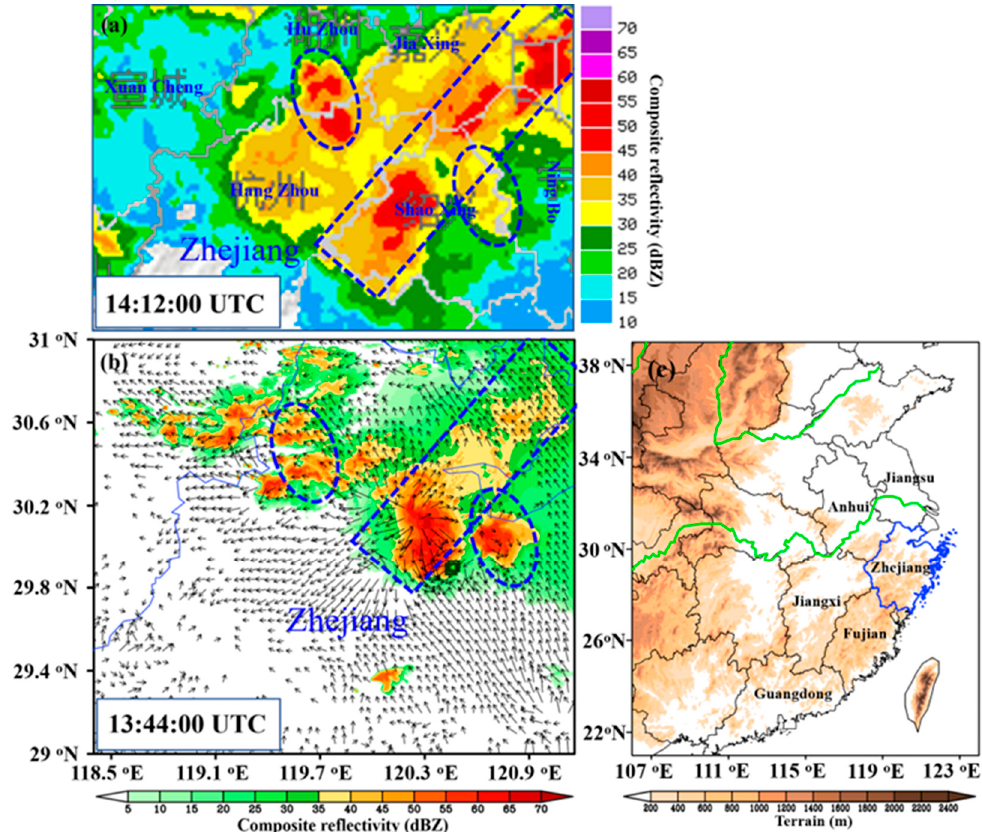
Figure 1. ( a ) Observed composite radar reflectivity (shading; dBZ) at 14:12:00 UTC 14 May 2021, where the dashed rectangle and ellipses mark the sections used for comparisons. ( b ) Simulated composite radar reflectivity (shading; dBZ), and surface wind (vector) at 13:44:00 UTC 14 May 2021, where the small green boxes mark the locations at which the tower toppling appeared, and the dashed rectangle and ellipses mark the sections used for comparisons. ( c ) Terrain (shading; m) and distribution of provinces, where the blue map highlights Zhejiang Province.